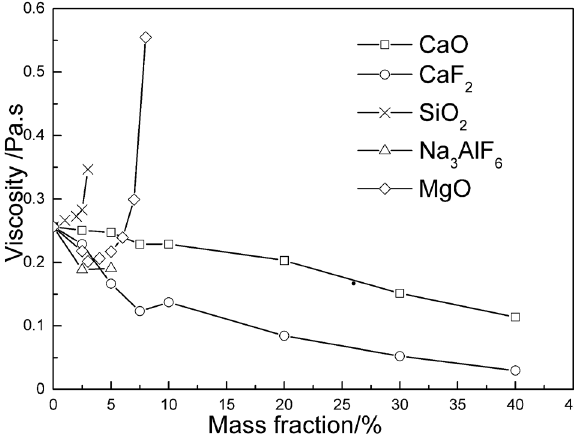
Figure 3: E ff ect of di ff erent additives on the viscosity of slags at 1,923 K ( 1,650°C )